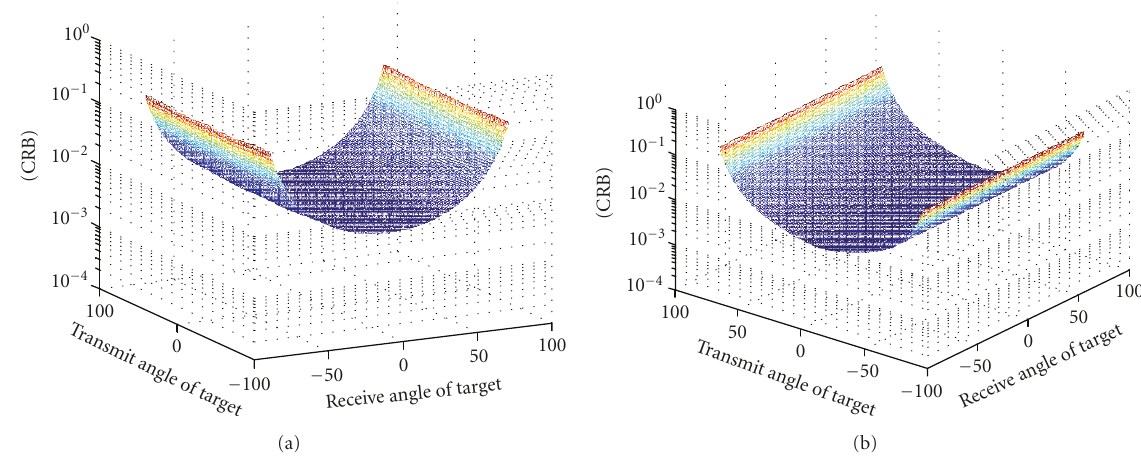
Figure 3: The CRB for bistatic MIMO radar, M = N = 3, L = 256, SNR = 8dB, σ 2 with transmit angle varying from − 80 ◦ to 80 ◦ ; (b) the CRB for transmit angle of range [ − 80 ◦ ,80 ◦ ] with receive angle varying from − 80 ◦ to 80 ◦ .